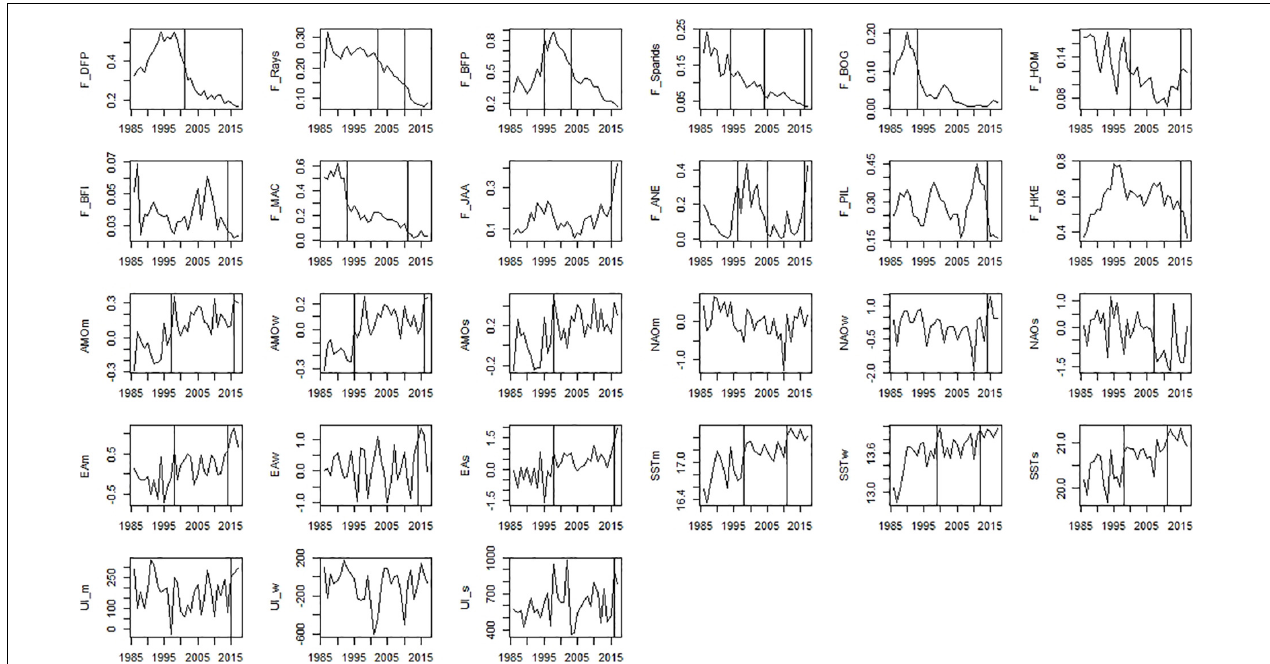
FIGURE 5 | Time-series of ecosystem drivers data that includes fishing mortality and environmental/climatic variables. Significant shifts detected by STARS analysis are displayed on the plots as solid and dashed vertical line for shifts significant at p ≤ 0.05 and ≤ 0.1, respectively. Abbreviations, used in the figure, are explained in Supplementary Table 4 .